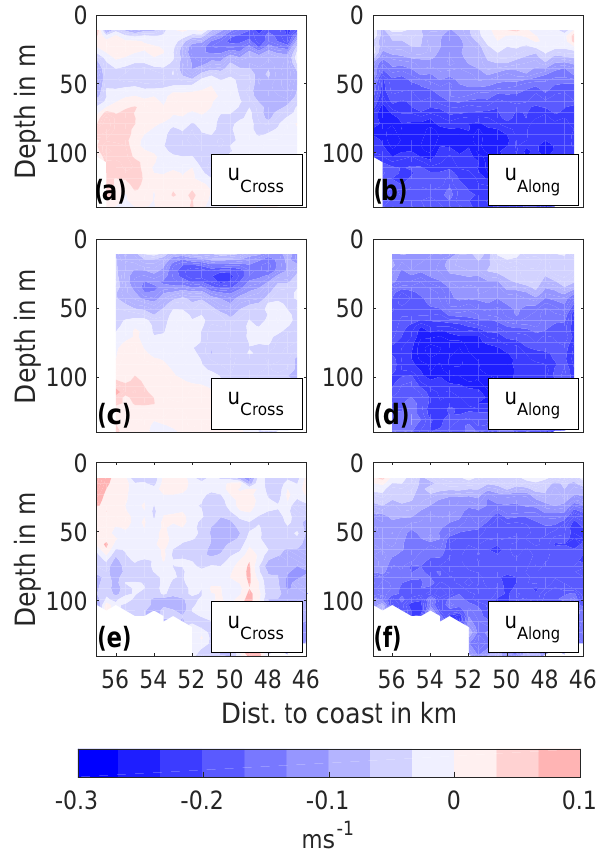
Figure 7. Mean cross- and along-front current velocities for cross- frontal transects 1–6 in (a) and (b) , 7–11 in (c) and (d) , and 12– 17 in (e) and (f) . Currents are horizontally binned onto a 500m grid and subsequently averaged.